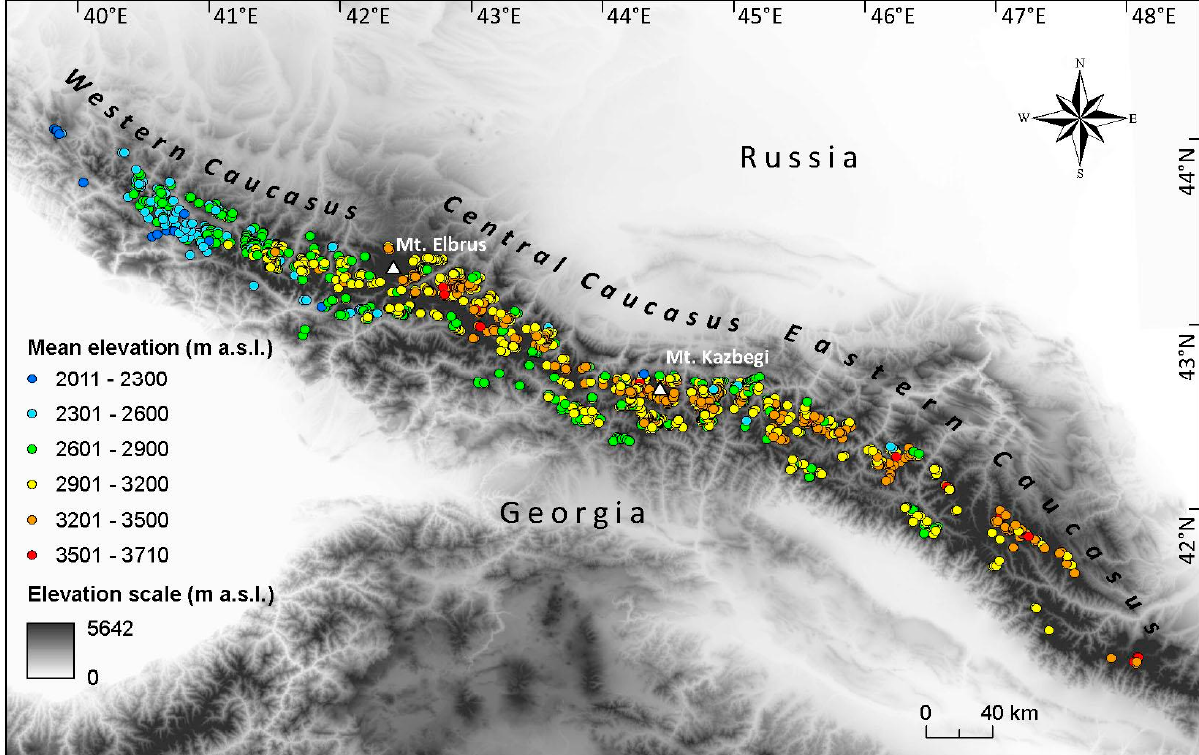
Figure 7. Color-coded map of mean elevation for all rock glaciers larger than 0.01 km 2 in the Greater Caucasus.